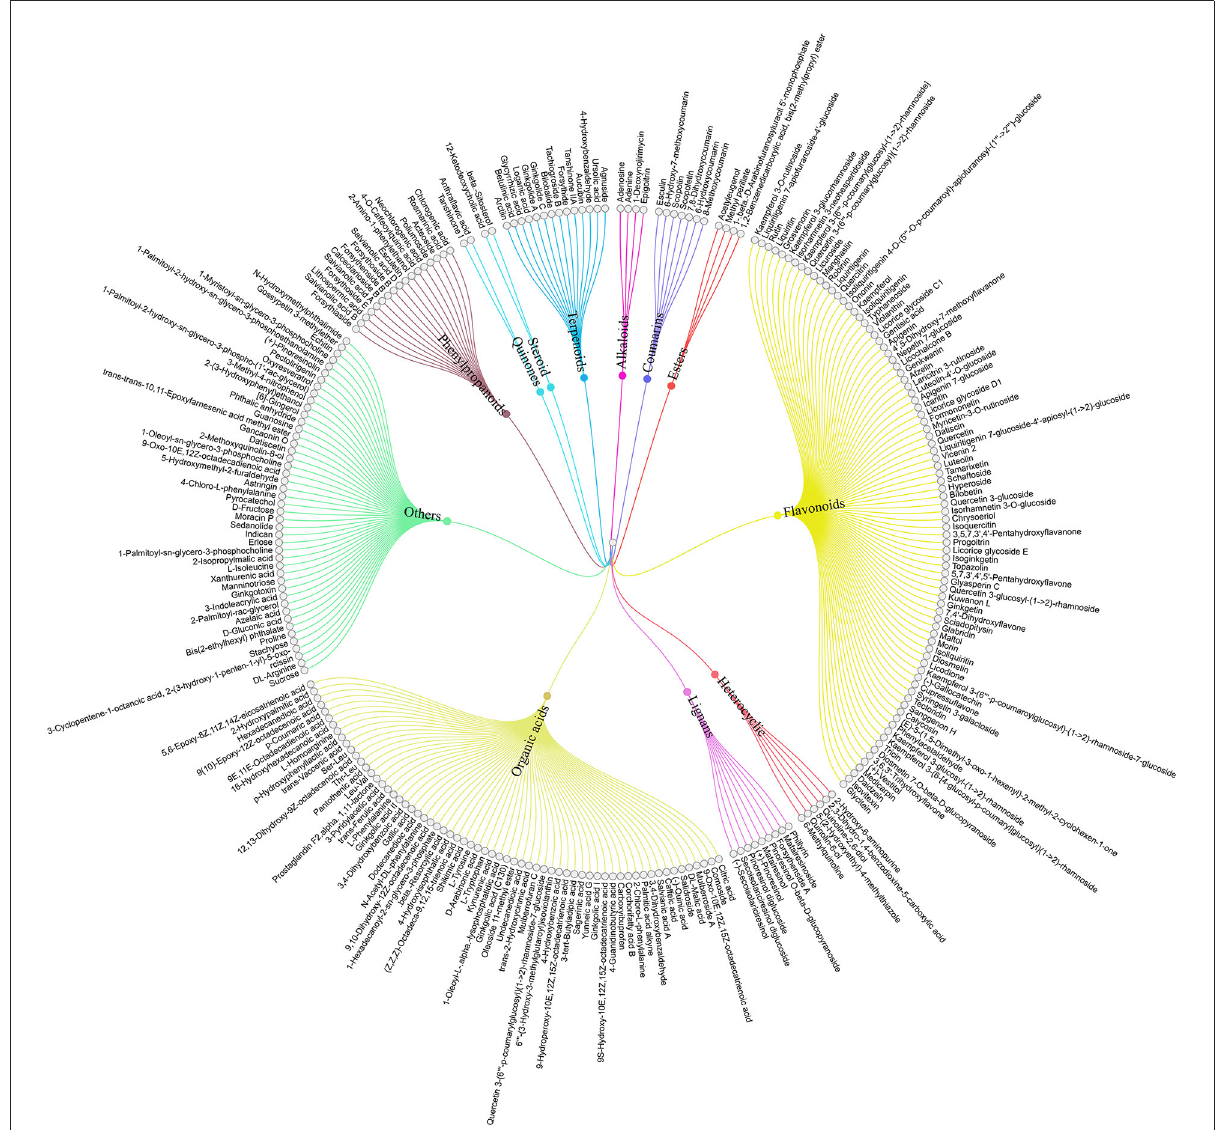
FIGURE3 Tree diagram of NCMC aqueous extraction classification. Total 260 compounds belong to 12 categories represented by different